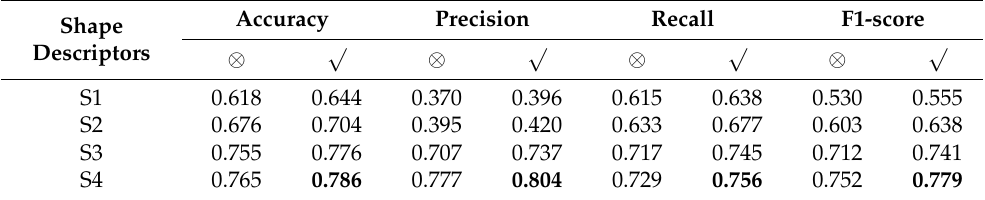
Table 4. Lenke classification results for the compared methods based on segmentation by U-Net++. ⊗ : √ the post-processing was not used; : the post-processing was used; the bold indicates the best results.